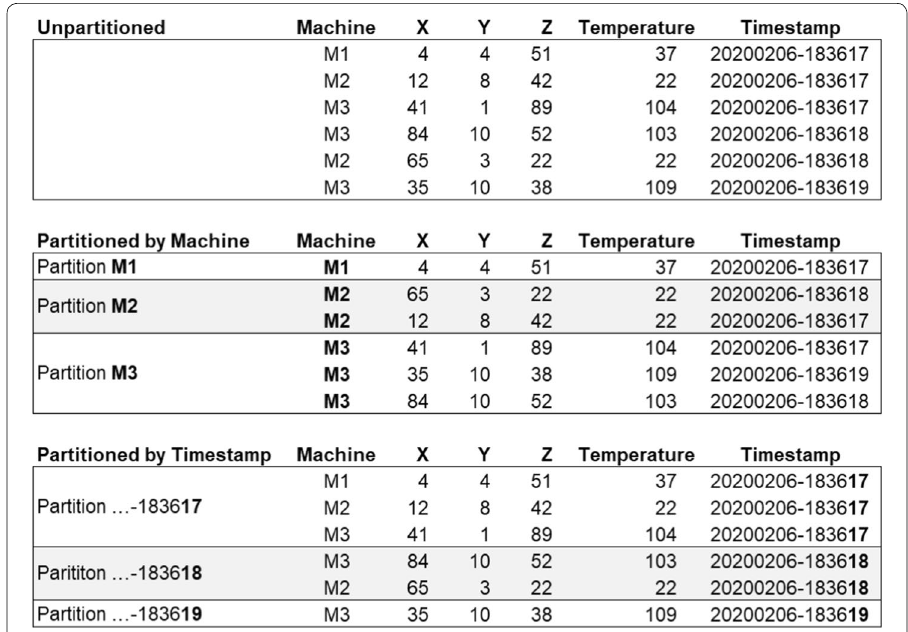
Fig. 3 Partitioning: Top part shows a dataset with measures of several machines. Middle and lower parts show how the data is rearranged when partitioned by Machine and Timestamp ,